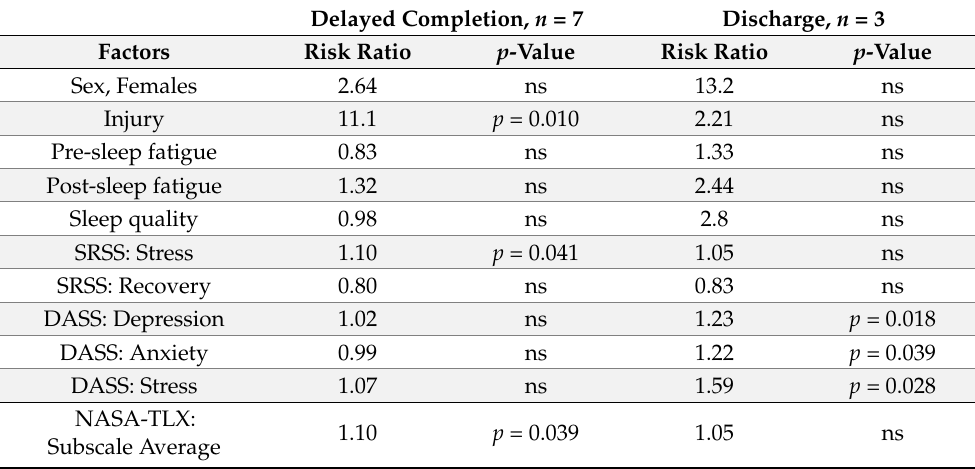
Table 5. Factors explaining the risk of delayed completion of